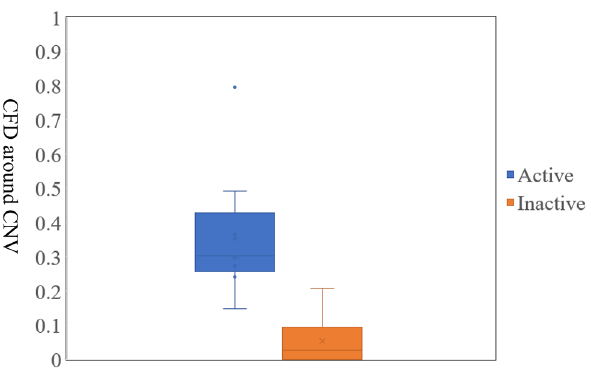
Figure 3. The box-and-whisker diagram of the activity (active/inactive) and size of the choriocapillaris flow